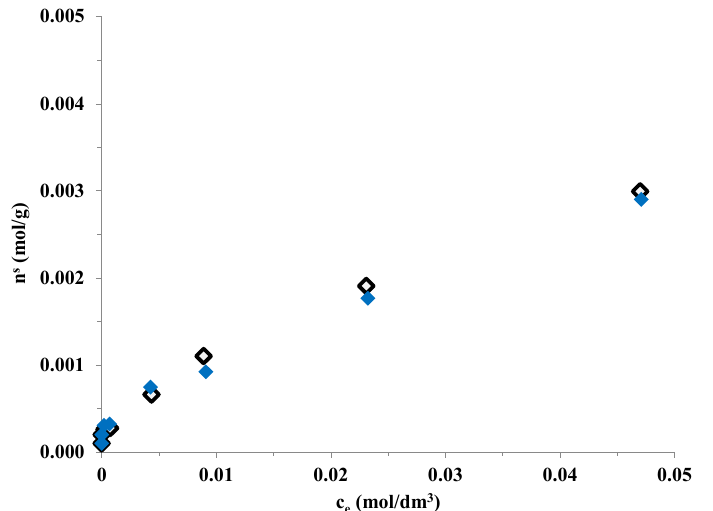
Figure 3. Adsorption isotherms of oxalic acid on bare Aeroxide P25 (◊) and 1 wt% Pt-modified Aeroxide P25 (  ) TiO 2 photocatalysts at 25.0